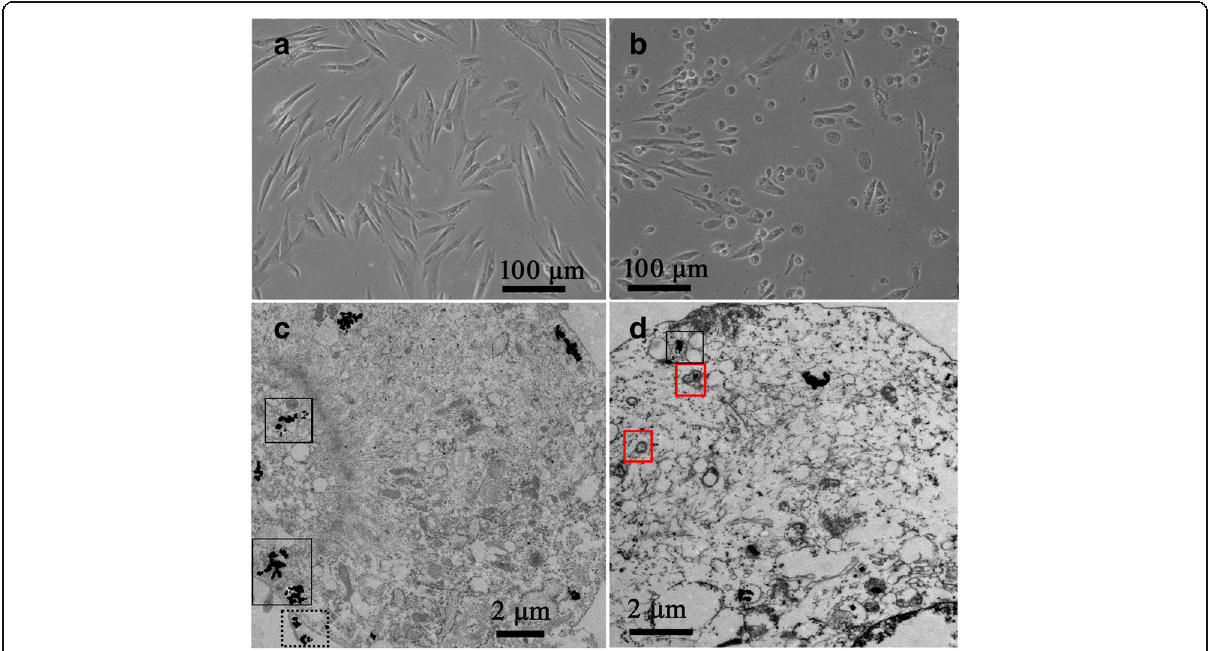
Fig. 7 The light microscopy images of HSF treated with A/A-ES before ( a ) and after irradiation ( b ). TEM images of HSF treated with A/A-ES before ( c ) and after irradiation ( d )